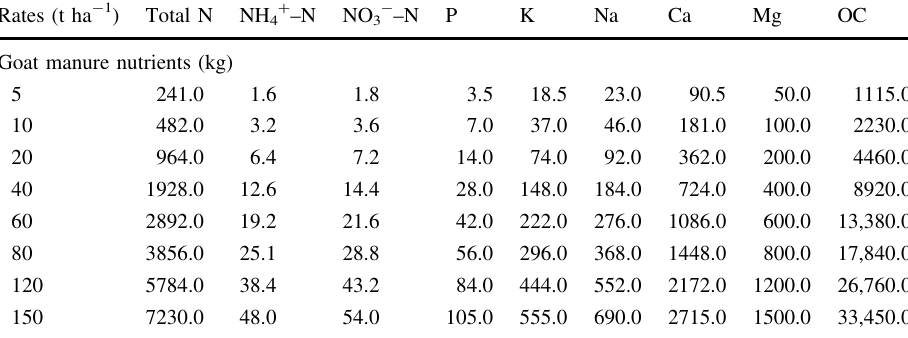
Table 3 Equivalent amount of nutrients present in goat manure rates added to the soil